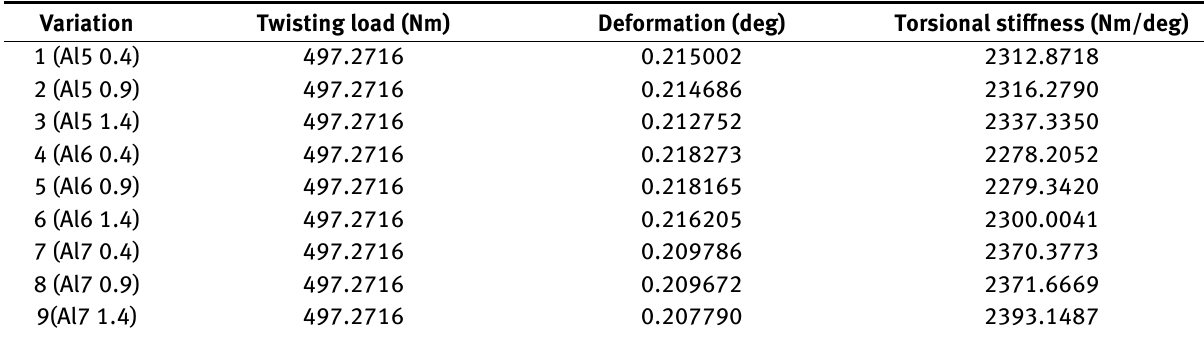
Table 10: Calculation of the torsional stiffness